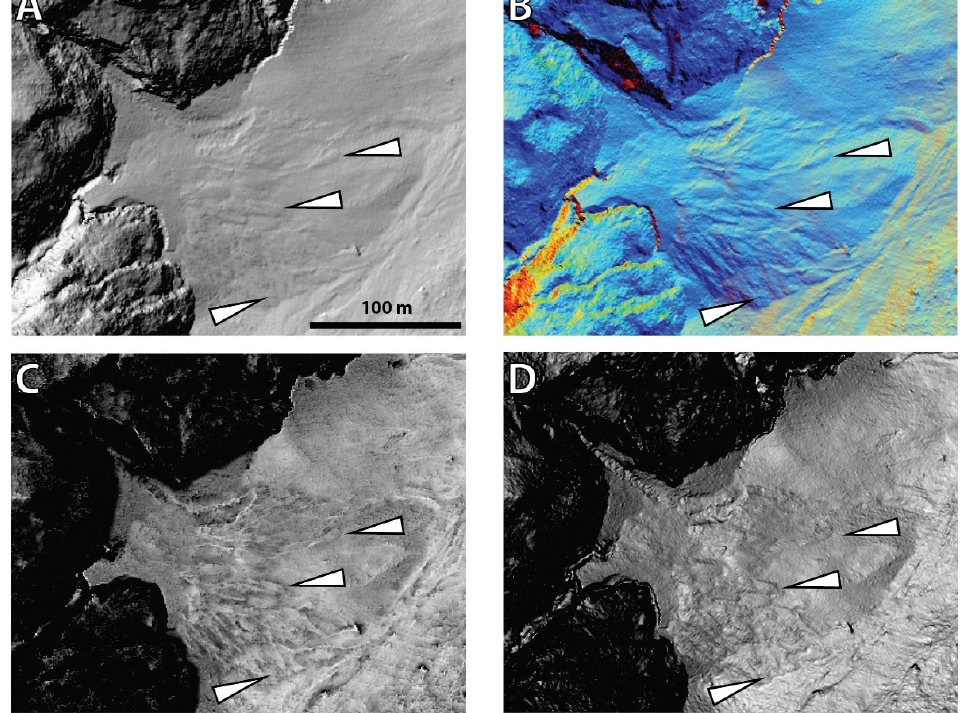
Figure 5. Example of sieve deposits represented on ( A ) Analytical hillshading (A315, H35), ( B ) Hillshading from multiple directions RGB (D16, H35), ( C ) 8-bit sky view factor, and ( D ) 8-bit slope visualisations. Individual sieve deposits in this case measure 10 by 5 m. For location see rectangle 5 in Figure 1.